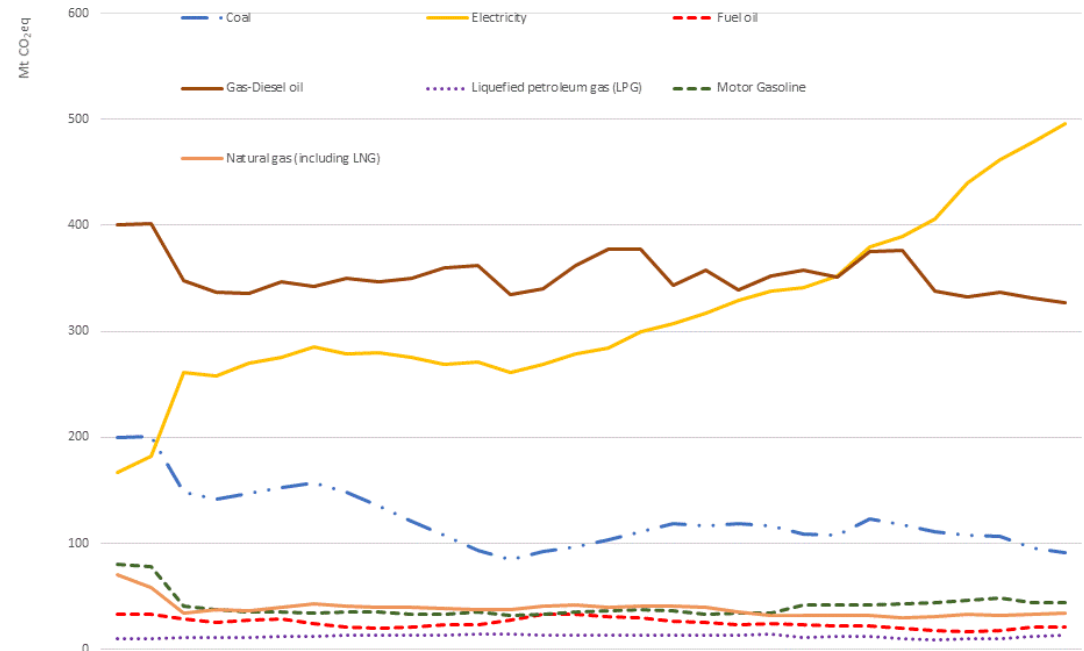
Figure 1. Global GHG emissions from energy use in agriculture from 1990 to 2019 by energy carrier (MtCO 2 eq). Source: FAOSTAT, based on data from IEA and UNSD